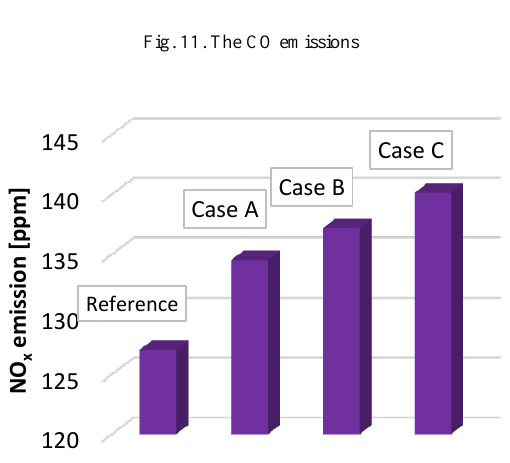
Fig. 11. The CO emissions